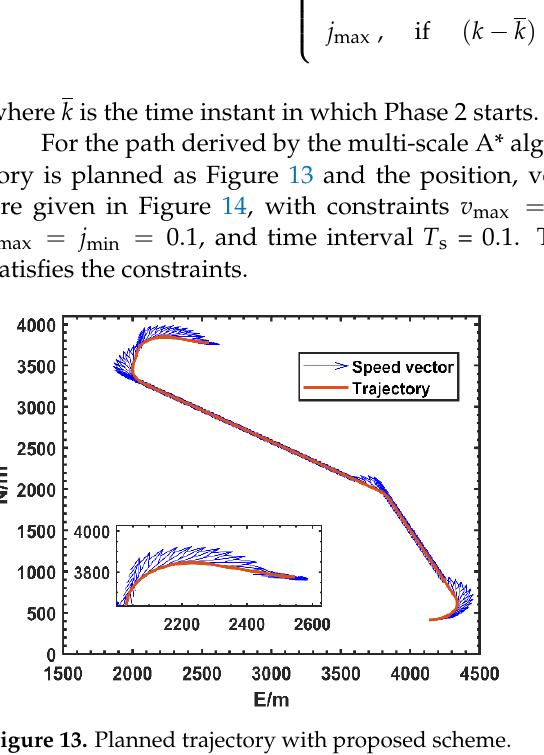
Figure 14. Planned profiles for position, velocity, acceleration, and jerk. The proposed scheme not only satisfies the requirement of forward navigation, but is also applicable for the navigation with forward and backward motions. When the final course orients outside of the port, the planned path may have segments with backward motion, as Figure 15 illustrates, where maximum curvature is set as 0.005, initial pose [ x 0 , y 0 , Ψ 0 ] = [4138, 417, 0], and final pose [ x 2 , y 2 , Ψ 2 ] = [3500, 3330, 0]. The corresponding motion configuration is given in Figure 16. The planned trajectory meets the constraints and realizes backward motion planning. Opened Closed 0 speed pointPlanned path Figure 15. Path planned with backward motion.